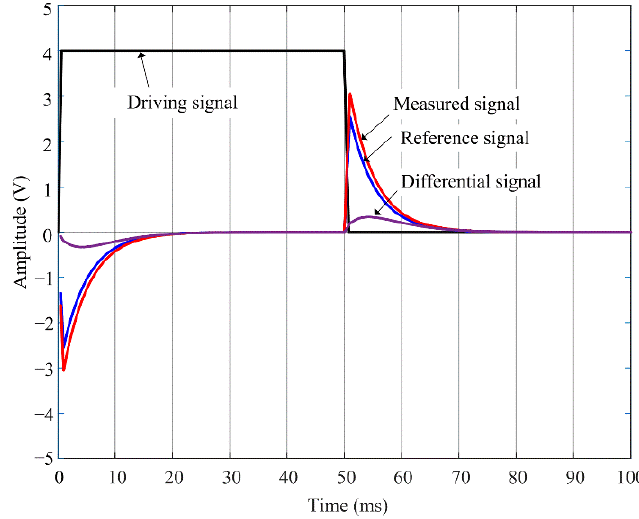
Figure 2. Typical PECT signals presented on a Cartesian plane.